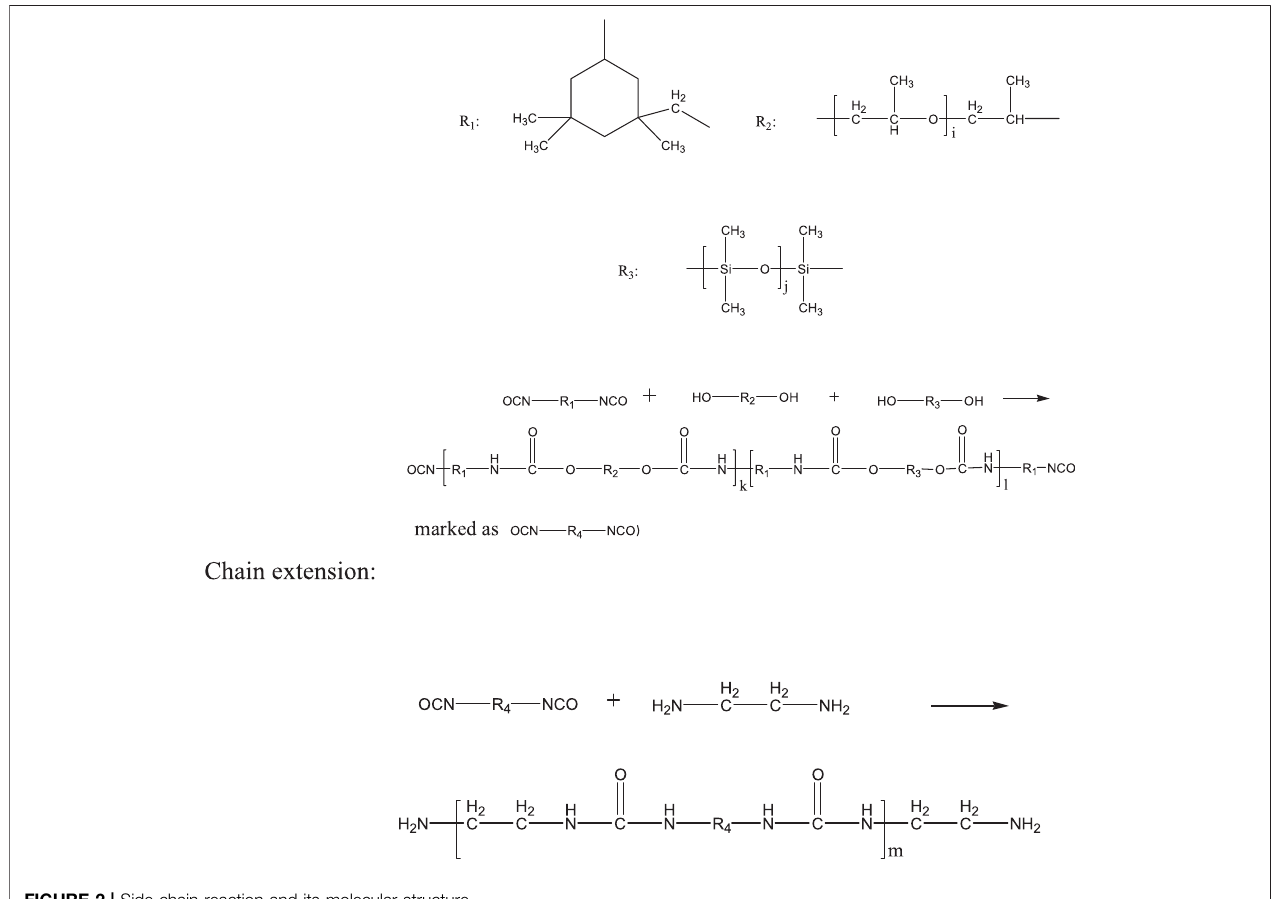
FIGURE 2 | Side chain reaction and its molecular